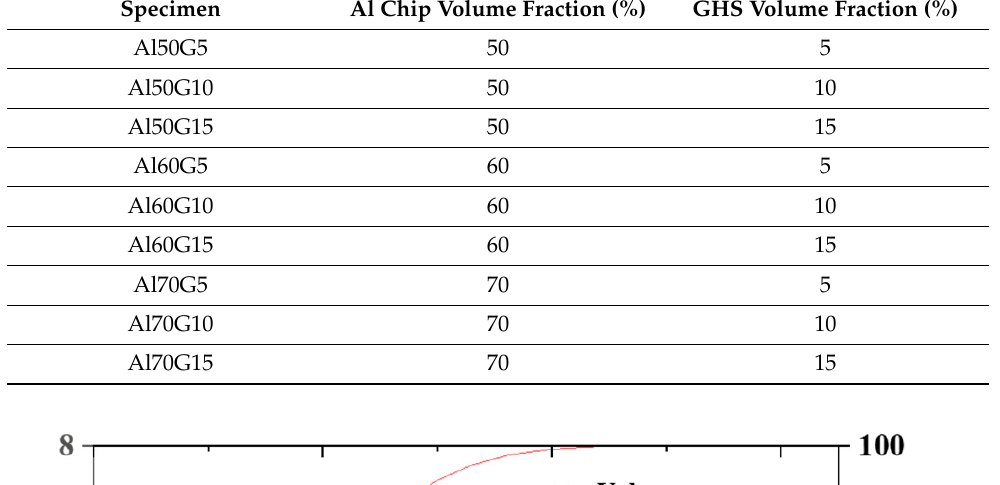
Figure 1. ( a ) Al chip size measurement; ( b ) Schematic of AlG foam process temperature and actual mold temperature measurements; ( c ) Mold temperature measurement method.